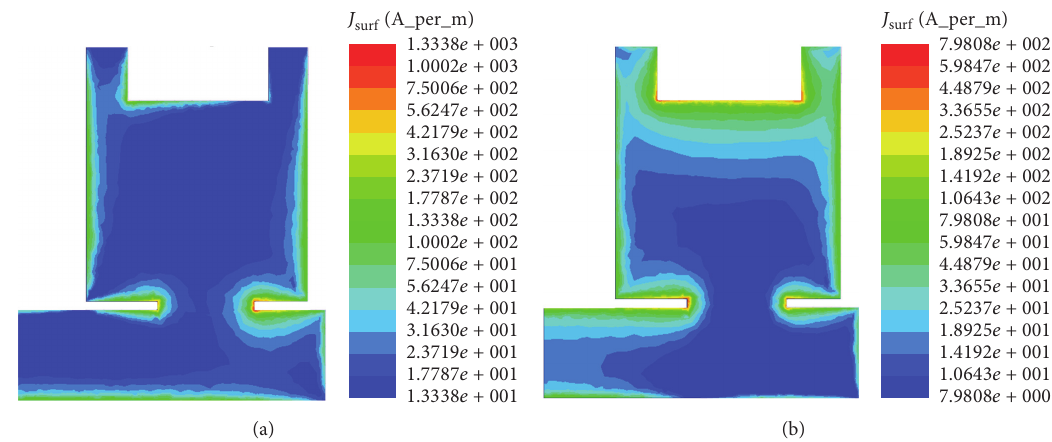
Figure 22: Simulated surface current distribution on the NB antenna at (a) 7.5GHz and (b) 9.5 GHz.